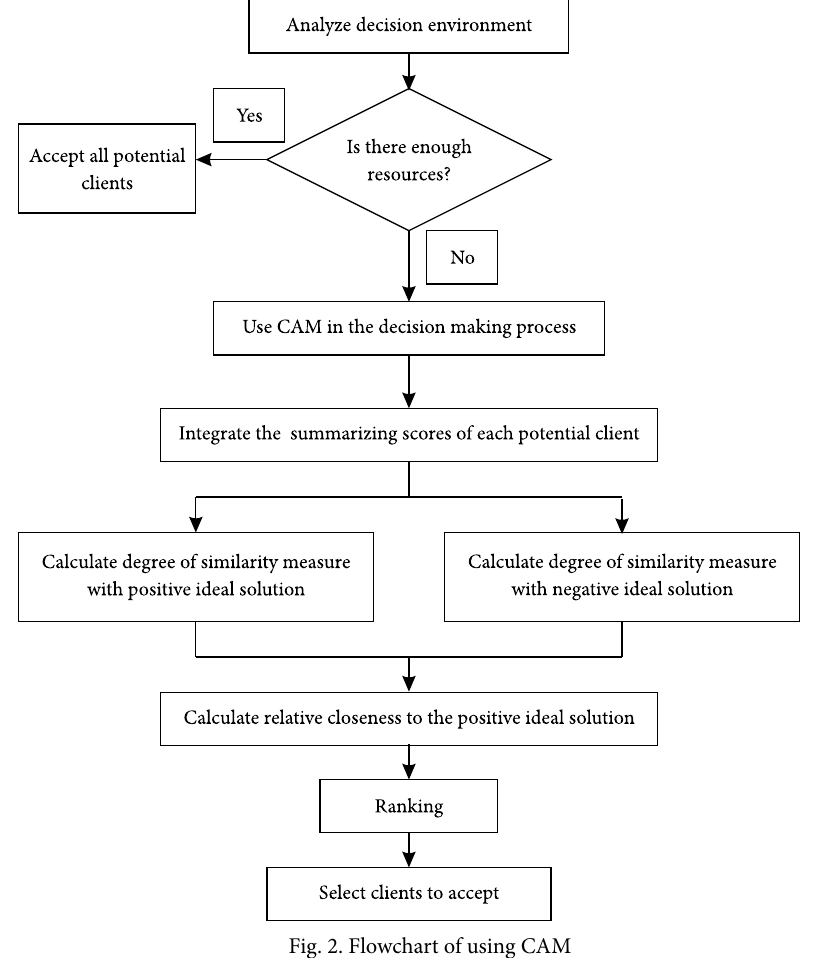
Fig. 2. Flowchart of using CAM Table 1. Nine-member linguistic terms and their corresponding interval-valued fuzzy numbers Linguistic